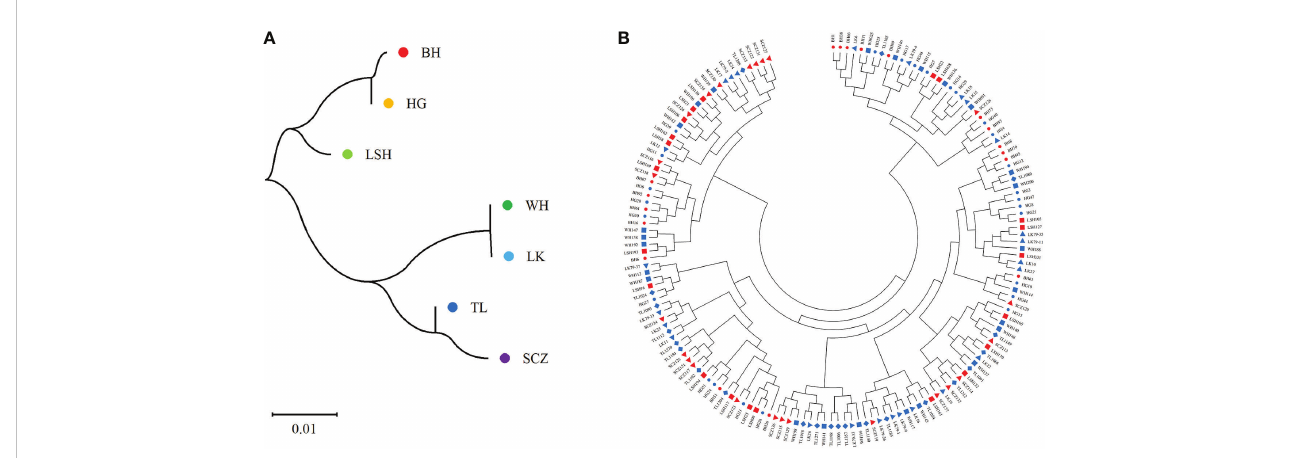
FIGURE 5 Neighbor-joining tree of populations and clones. (A) Neighbor-joining tree of 7 populations. (B) Neighbor-joining tree of 161Korean pine clons. (BH, Bohai; HG, Hegang; LSH, Lushuihe; WH, Weihe; LK, Linkou; TL, Tieli; SCZ,